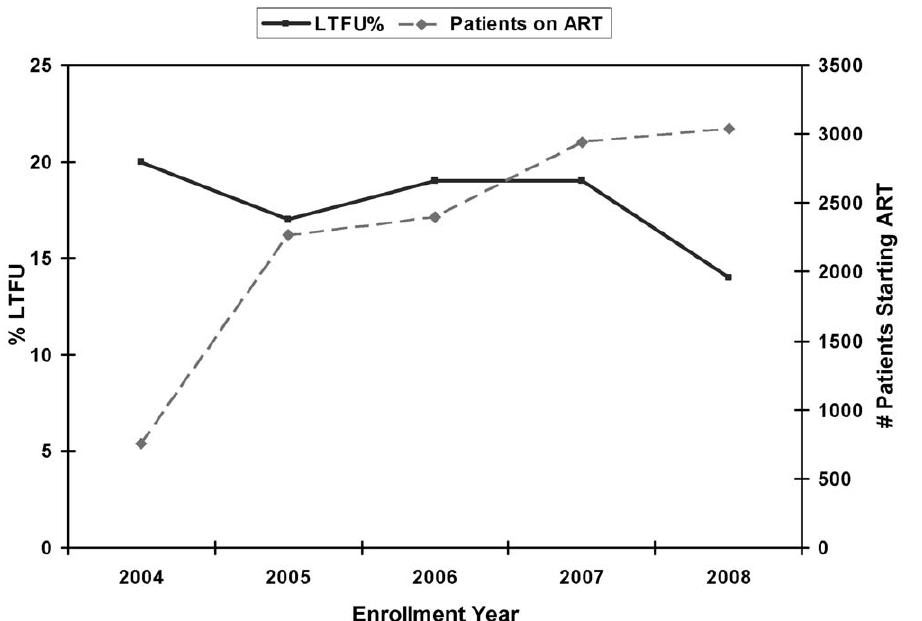
Figure 2. Trends in LTFU and program size in the Catholic Relief Services/Southern African Catholic Bishops Conference HIV treatment program, 2004–2008.